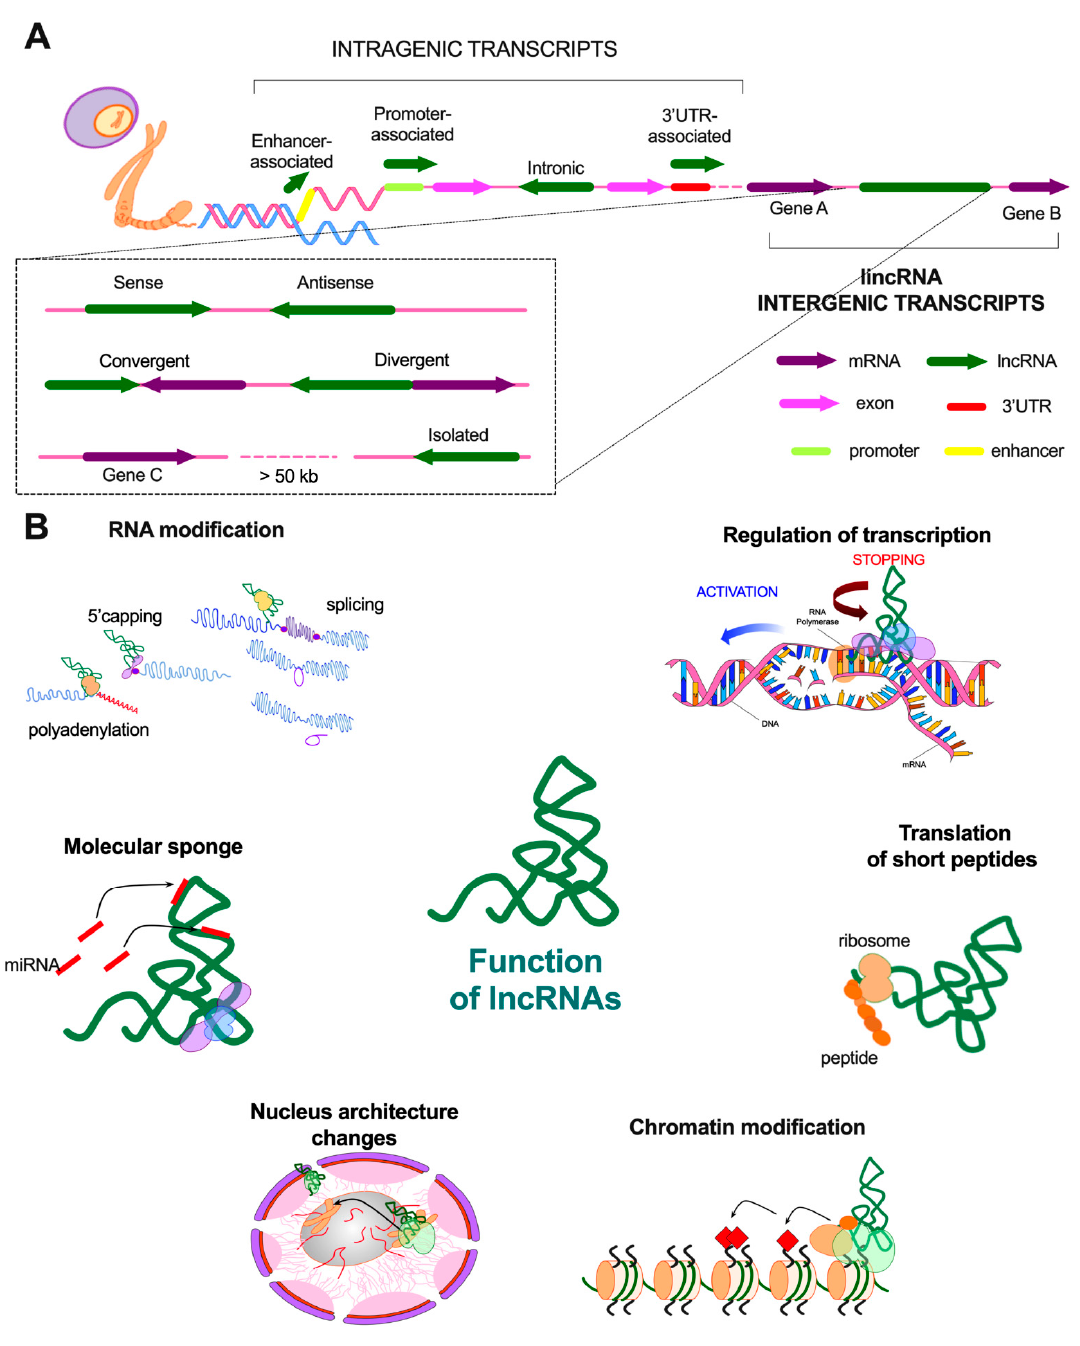
Figure 1. Characteristics of lncRNAs: ( A ) the classification of transcripts depending on the localization in the genome; ( B ) the main biological functions of lncRNAs, including modification of RNA as well as chromatin, changes in nucleus architecture, molecular sponging, production of short peptides, and regulation of transcription.